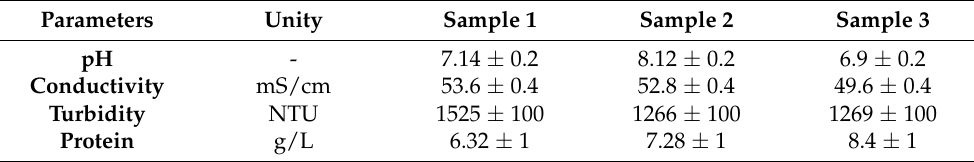
Table 1. Physicochemical characteristics of the industrial tuna cooking juices.